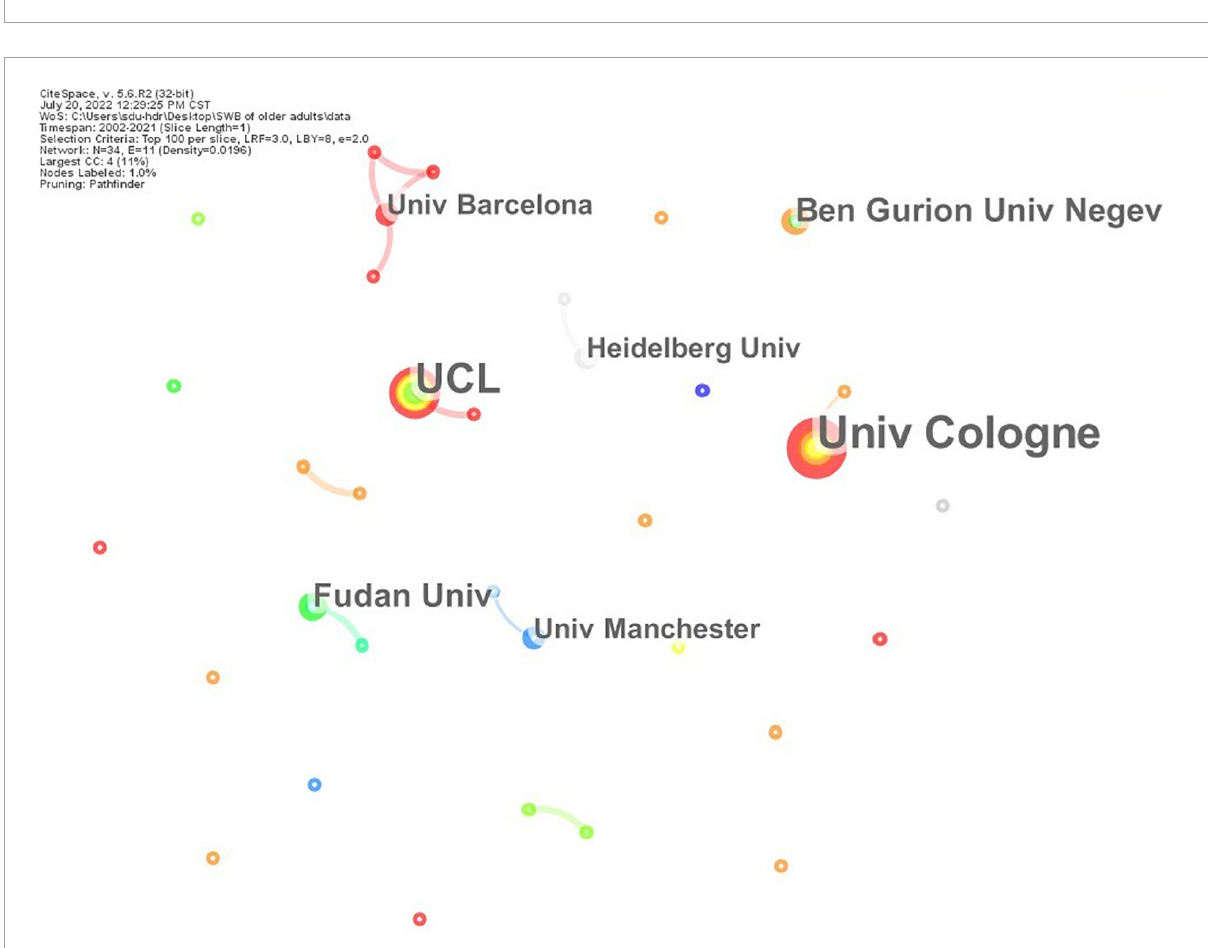
FIGURE3 Co-authorship network of organizations. A circle represents an institution, and the size of the circle represents the frequency of publications. The connection between nodes represents the cooperation relationship, and the thickness of the line represents the frequency of